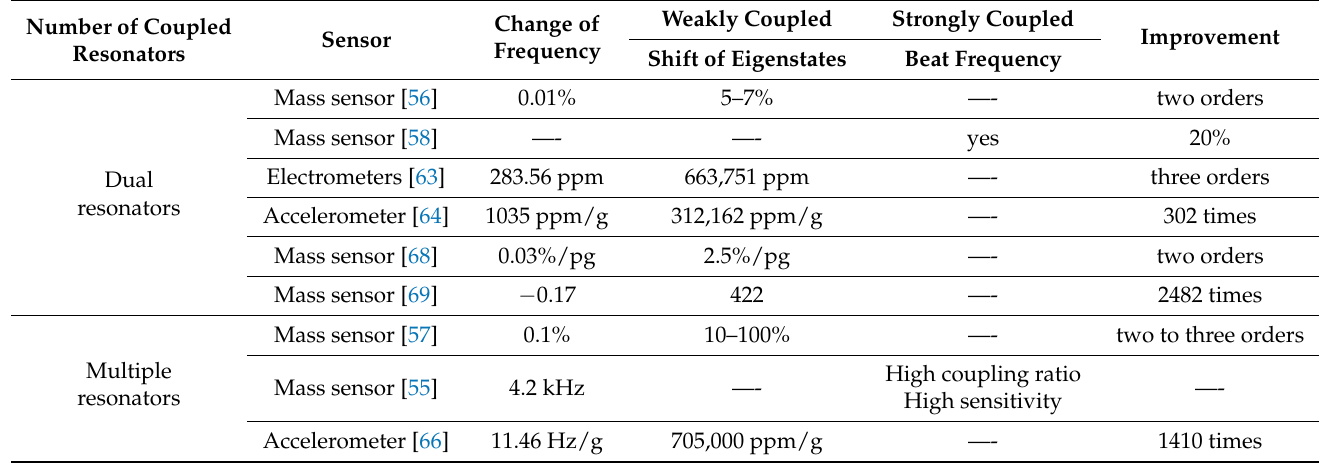
Table 2. Comparisons of properties of different ME-SCRB